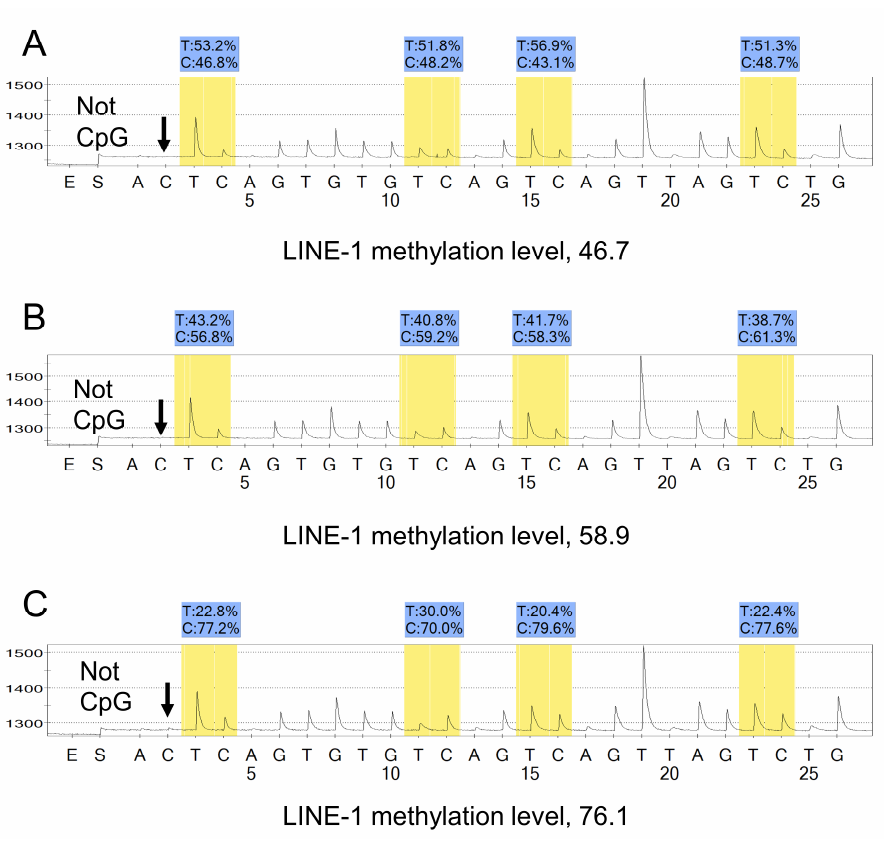
Figure 2. Pyrosequencing assay to measure LINE-1 methylation. ( A ) Tumor with LINE-1 hypomethy- lation (methylation level of 46.7). ( B ) Tumor with LINE-1 methylation level of 58.9. ( C ) Tumor with LINE-1 methylation level of 76.1. In panels A–C, the % numbers (in blue shade) are proportions of T and C nucleotides at each CpG site after bisulfite conversion. The proportion of C nucleotides (%) can be interpreted as the methylation level of each CpG site. The first, third, and fourth CpG sites follow mononucleotide T repeats, resulting in higher T peaks (in yellow shade) than the second CpG site. Accordingly, the proportion of C nucleotides (%) has been adjusted. No residual C nucleotides at the non-CpG site are indicated by the arrows, providing evidence for a complete bisulfite conversion reaction. We used the average of the proportions of C nucleotides at the 4 CpG sites as the LINE-1 methylation level (a scale of 0 to 100) of each tumor. To avoid confusion with other % numbers, “%” is not used for this LINE-1 methylation level to keep consistency between the text, tables, and figures. Abbreviation: LINE-1, long interspersed nucleotide